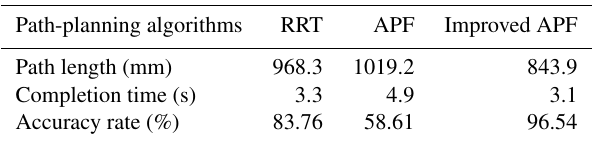
Table 2. Performance comparison of path-planning algorithms in the actual obstacle of the bending